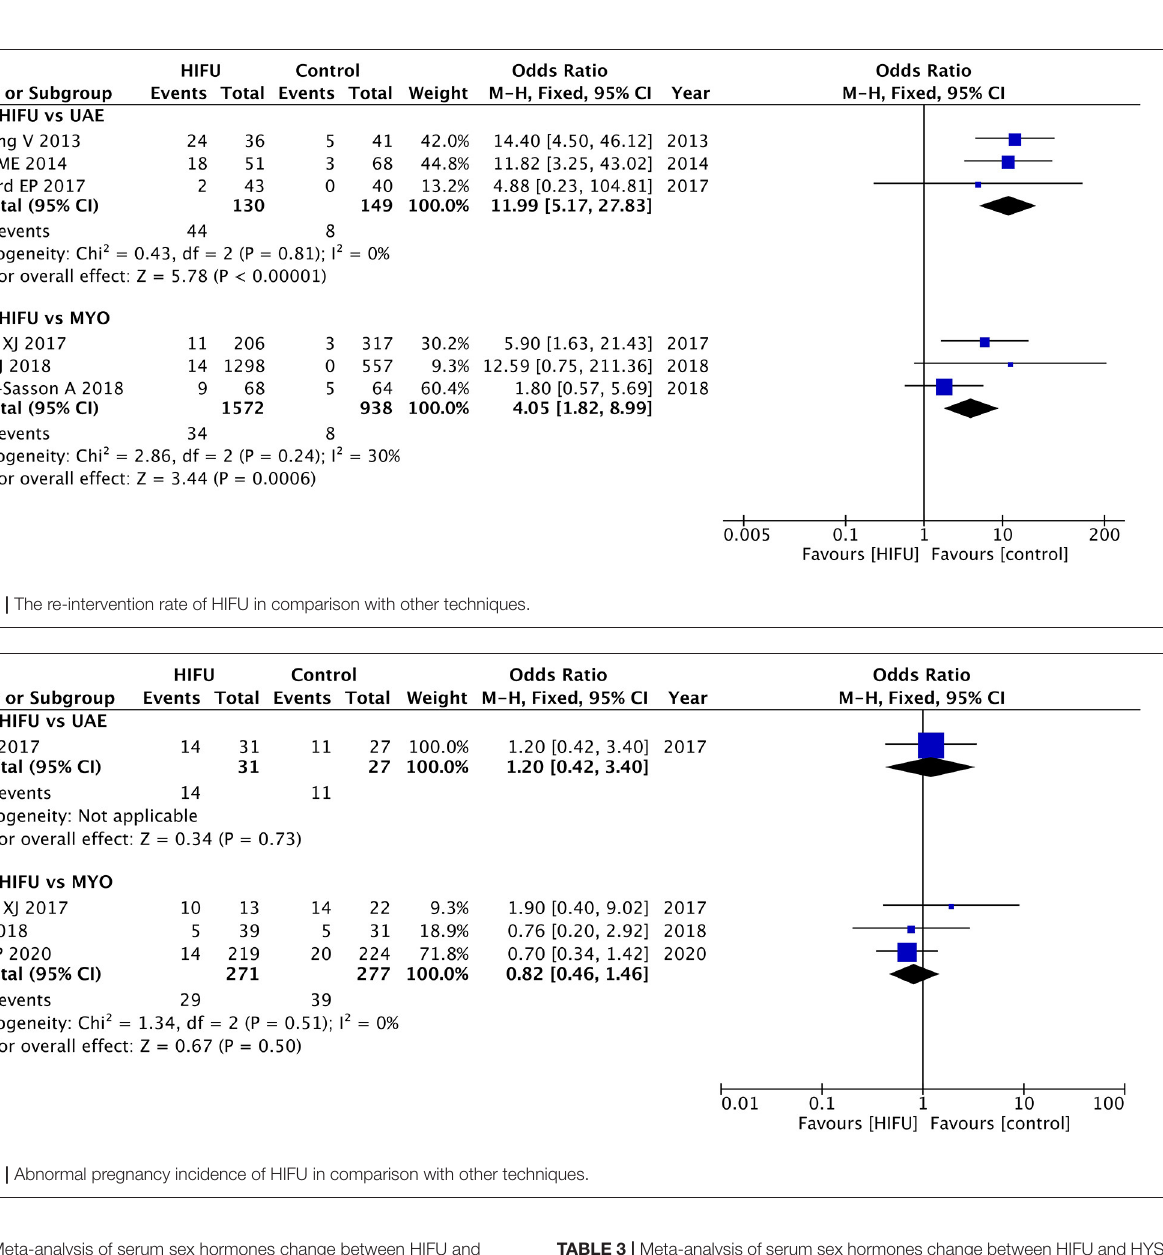
TABLE 3 | Meta-analysis of serum sex hormones change between HIFU and